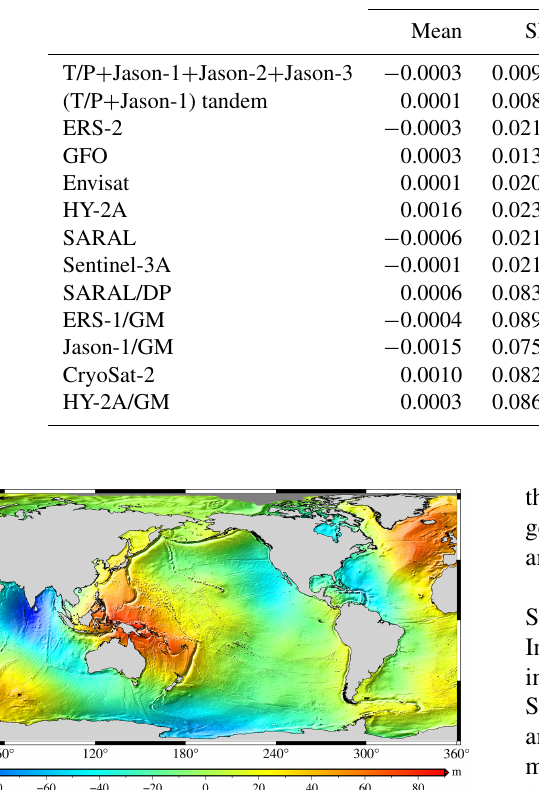
Table 3. Statistical results of crossover differences of different altimeter missions before and after self-crossover adjustment (unit: m). Missions